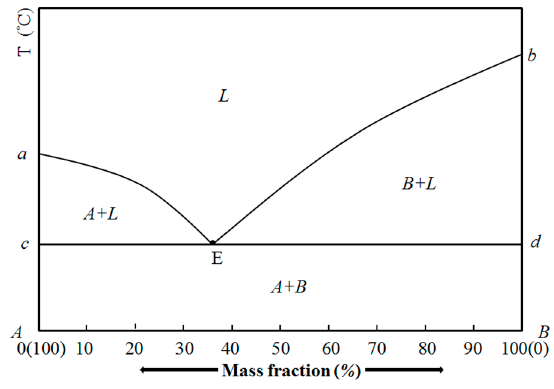
Figure 2. Phase diagram of a binary eutectic mixture system.